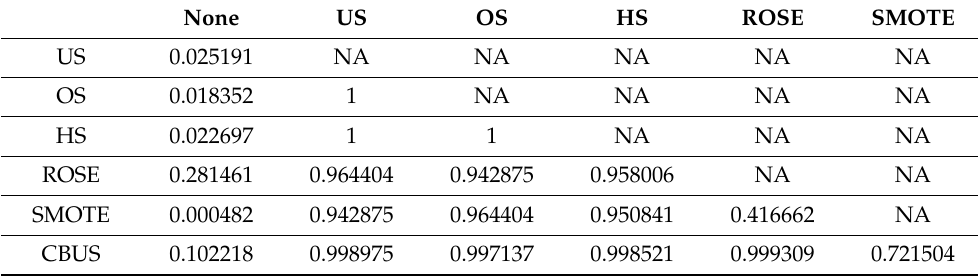
Table 10. Post hoc analysis using Nemenyi multiple comparison test for LR.